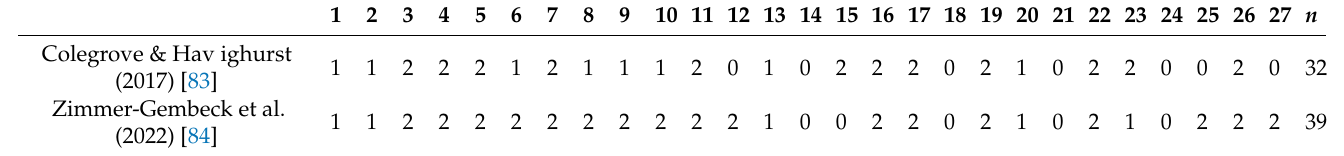
Table A3. Quality Estimation of the Included Systematic Reviews Using the PRISMA 2020